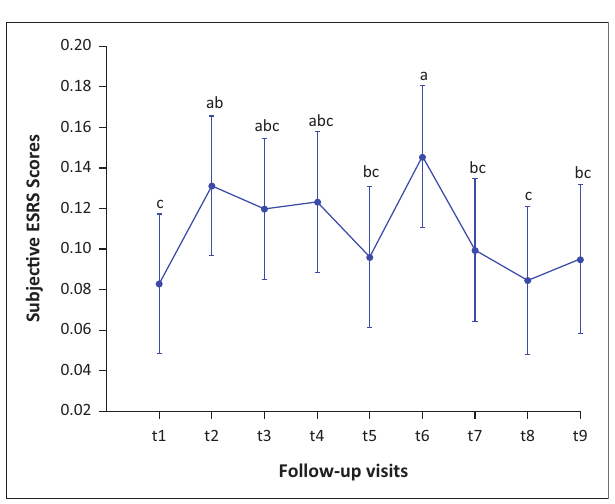
FIG URE 3: Subjective Extrapyramidal Symptom Rating Scale scores least square means over 12-month